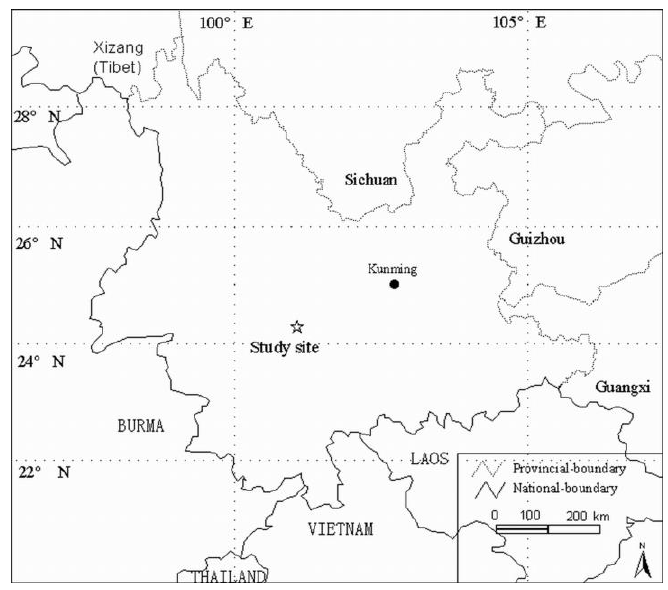
Figure 1. The location of the study site in the Ailao Mountains, Yunnan, Southwest China.